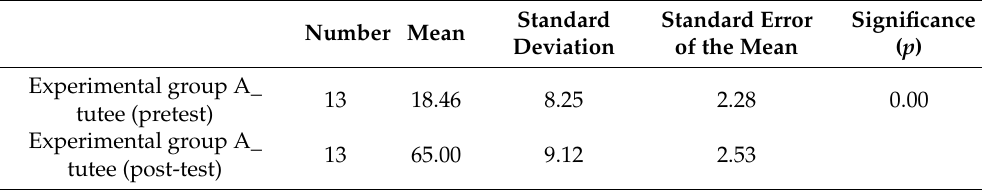
Table 7. Pretest and post-test t -test analyses of Experimental group